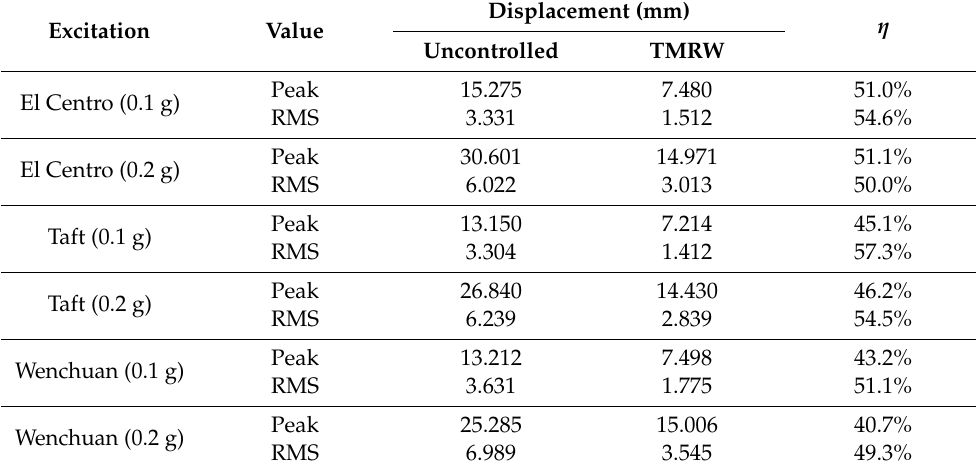
Table 1. Control effectiveness of the displacement responses (the second floor).